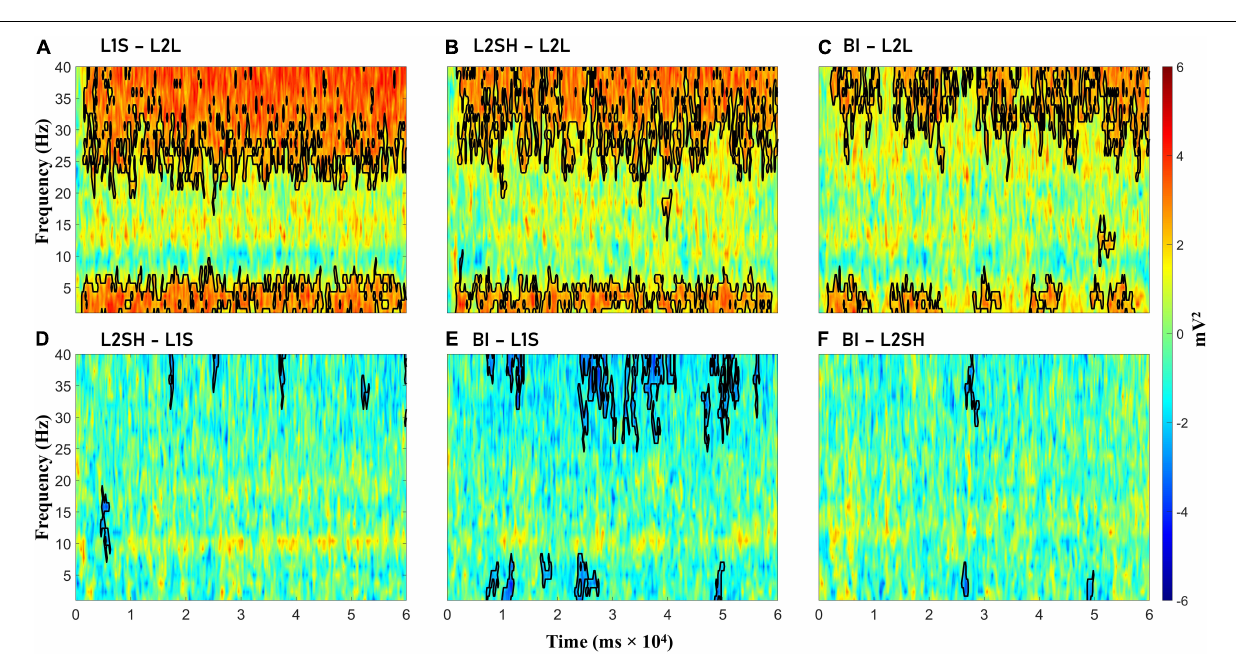
FIGURE 3 | Condition-wise time-frequency power differences. (A) L1 speaking (L1S) minus L2 listening (L2L). (B) L2 shadowing (L2SH) minus L2L. (C) Backward interpreting (BI) minus L2L. (D) L2SH minus L1S. (E) BI minus L1S. (F) BI minus L2SH. Statistically significant differences are marked with black